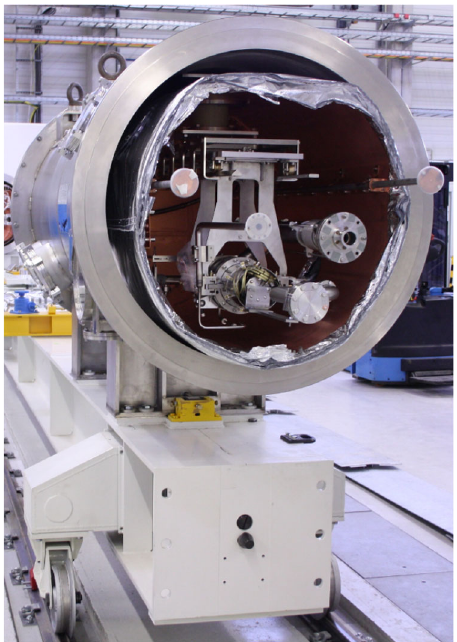
FIG. 2. The cavity package installed in the cryoadapter before connection to the XATB1 cryogenic feedbox. The cavity is supported by a sliding mechanism to the stainless steel suspen- sion support, which reproduces the mechanical installation in the accelerating module